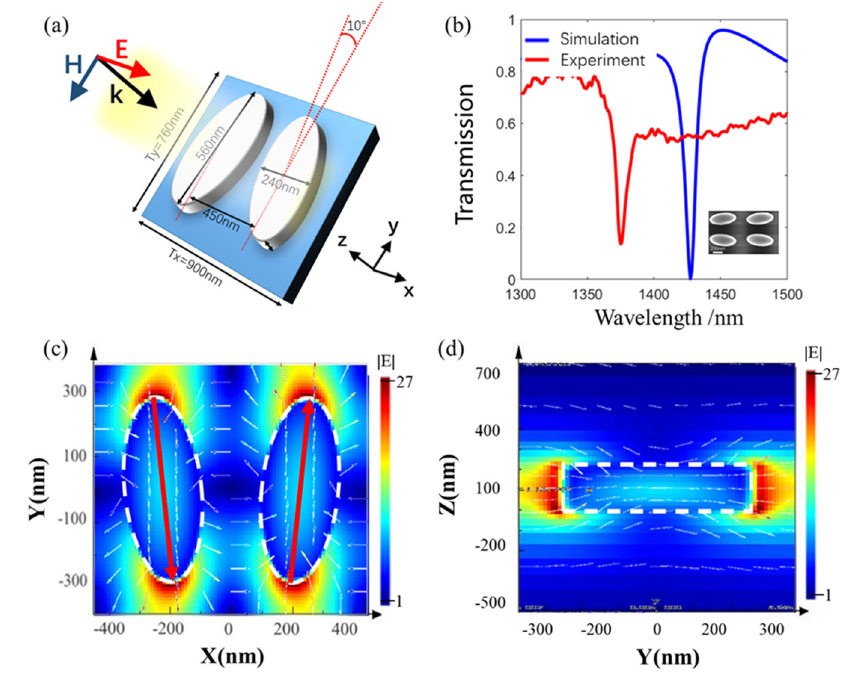
Figure 2. Design and characterization of the dielectric metasurface. ( a ) Diagram of the elliptical silicon disc pair. ( b ) Transmission spectra obtained in experiment and simulation. Inset shows a scanning electron microscope image of the fabricated metasurface. ( c , d ) The electric field diagram and the electric field vector diagram of the metasurface at the resonance wavelength of 1427 nm in XY-plane and YZ-plane.